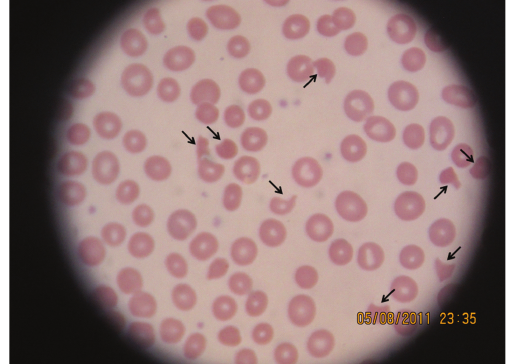
Figure 1: Peripheral smear at admission showing evidence of mi- croangiopathic hemolytic anemia with numerous schistocytes (ar- rows).